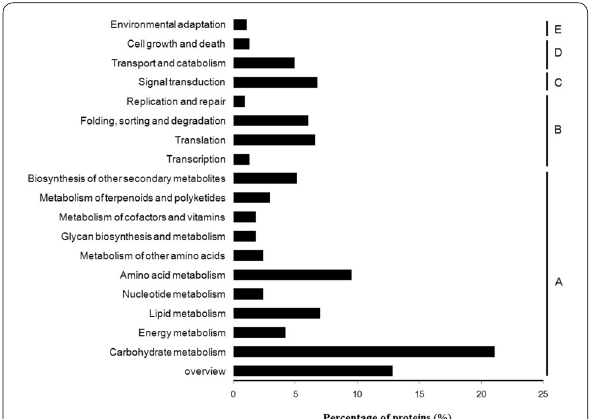
Fig. 3 KEGG annotation of the total proteins. A Cellular processes; B Environmental information processing; C Genetic information processing; D Metabolism; E Organismal systems